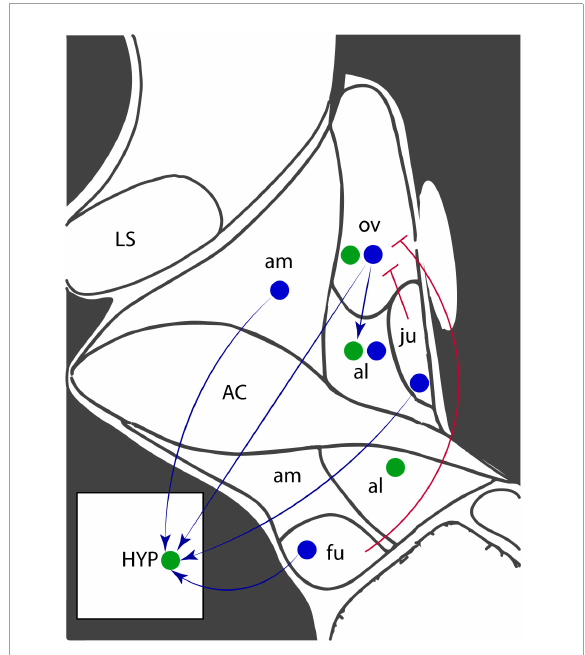
FIGURE1 Corticotropin-releasing factor (CRF) and receptor expression in the anterodorsal region of the BNST. Coronal diagram of the mouse anterior BNST, based on the Allen Brain Atlas. Blue circles represent CRF-expressing neurons and green circles represent CRF receptor-expressing neurons. Arrows indicate projections while blunted arrowheads indicate inhibitory projections. AC, anterior commissure; al, anterolateral nucleus; am, anteromedial nucleus; fu, fusiform nucleus; HYP, hypothalamus; LS, lateral septum; ju, juxtacapsular nucleus; ov, oval